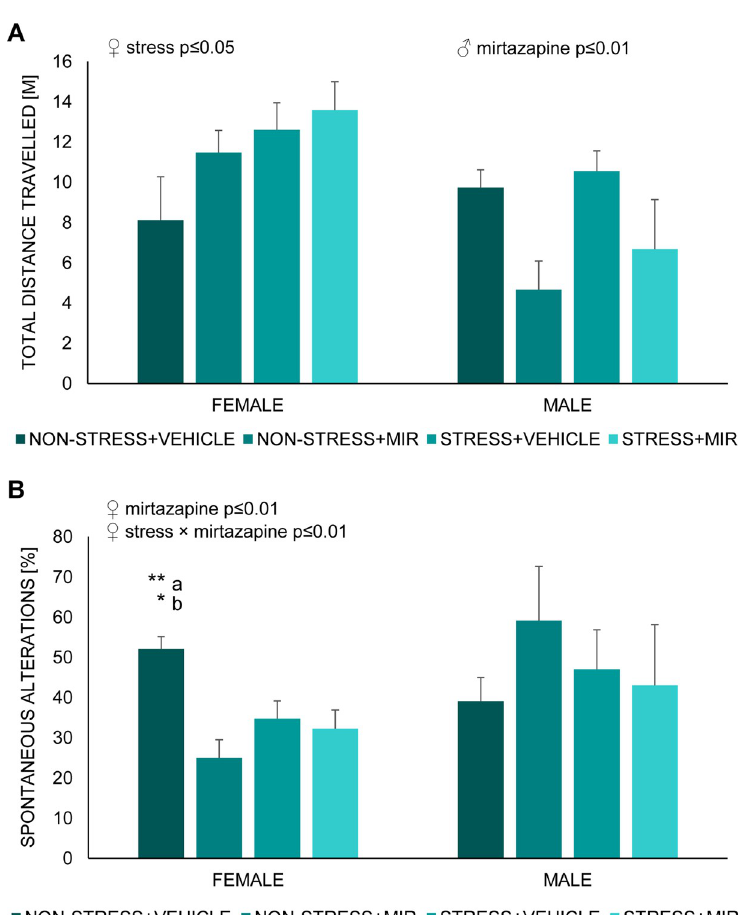
Fig 9. Y-maze of adolescent offspring. (A) total distance travelled, (B) percentage of spontaneous alterations. Data represent mean ± SEM. n = 5–8 animals/group/sex. a- compared to non-stress × mirtazapine, b- compared to stress × vehicle, � p � 0.05, �� p �